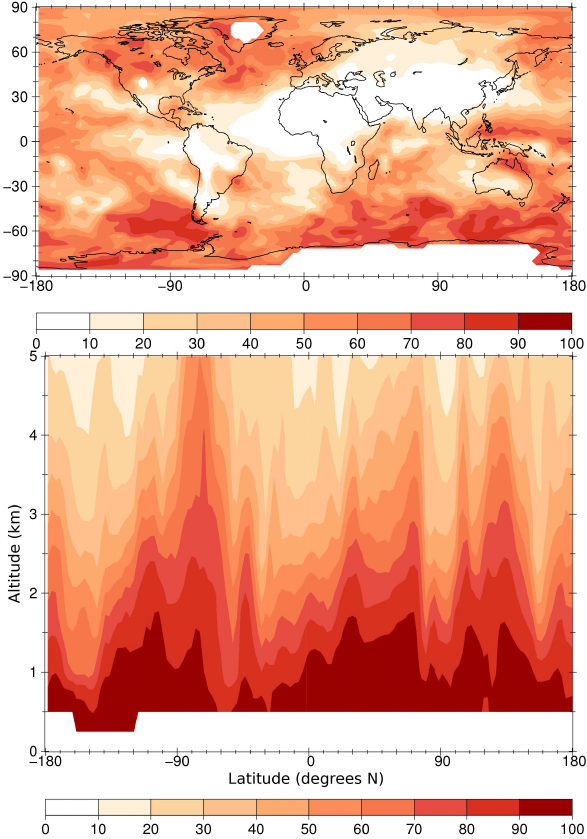
Fig. 6. Simulated relative contribution of marine biogenic IN at − 15 ◦ C, as a percent of annual mean dust IN and marine biogenic IN (“control” dust IN and “high” biogenic IN concentrations). Top: horizontal cross-section at 2km altitude. Bottom: vertical cross- section at 60 ◦ S